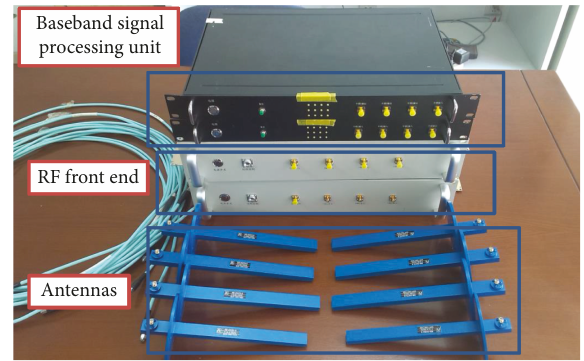
Figure 6: The prototype of the RF relative measurement